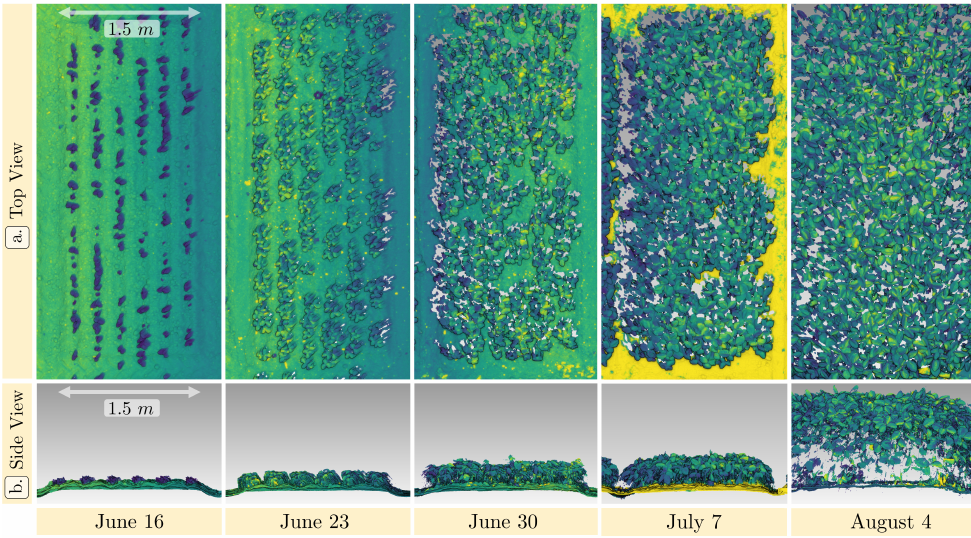
Figure 10. Plot of soybean plants at five different days within the growing season: ( a ) top view of the scanned plot; ( b ). side view of the